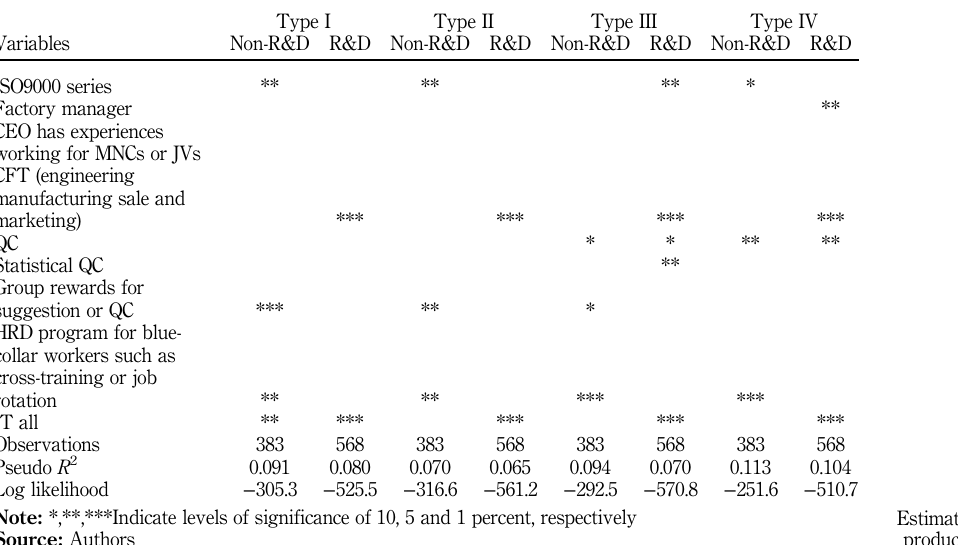
Table V. Estimation result